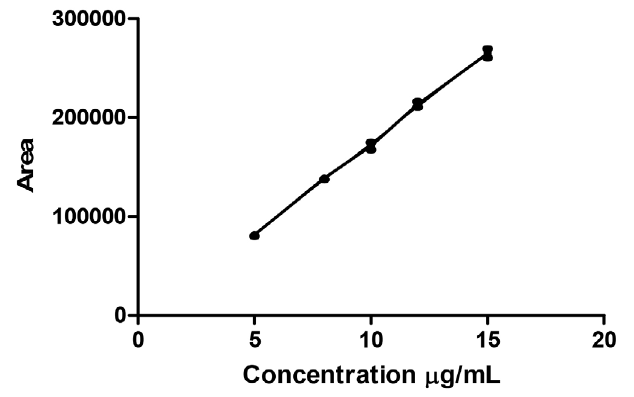
FIGURE 3 - Analytical curve of